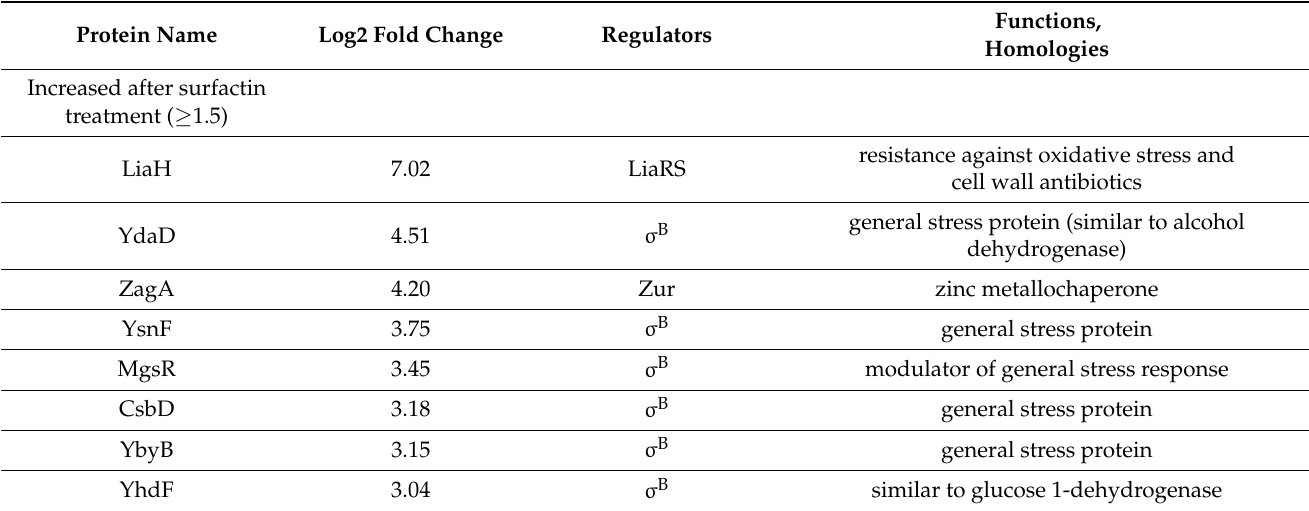
Table 2. Proteins significantly affected in their abundance after surfactin treatment. Proteins were only listed with differences ≥ 1.5 or ≤−